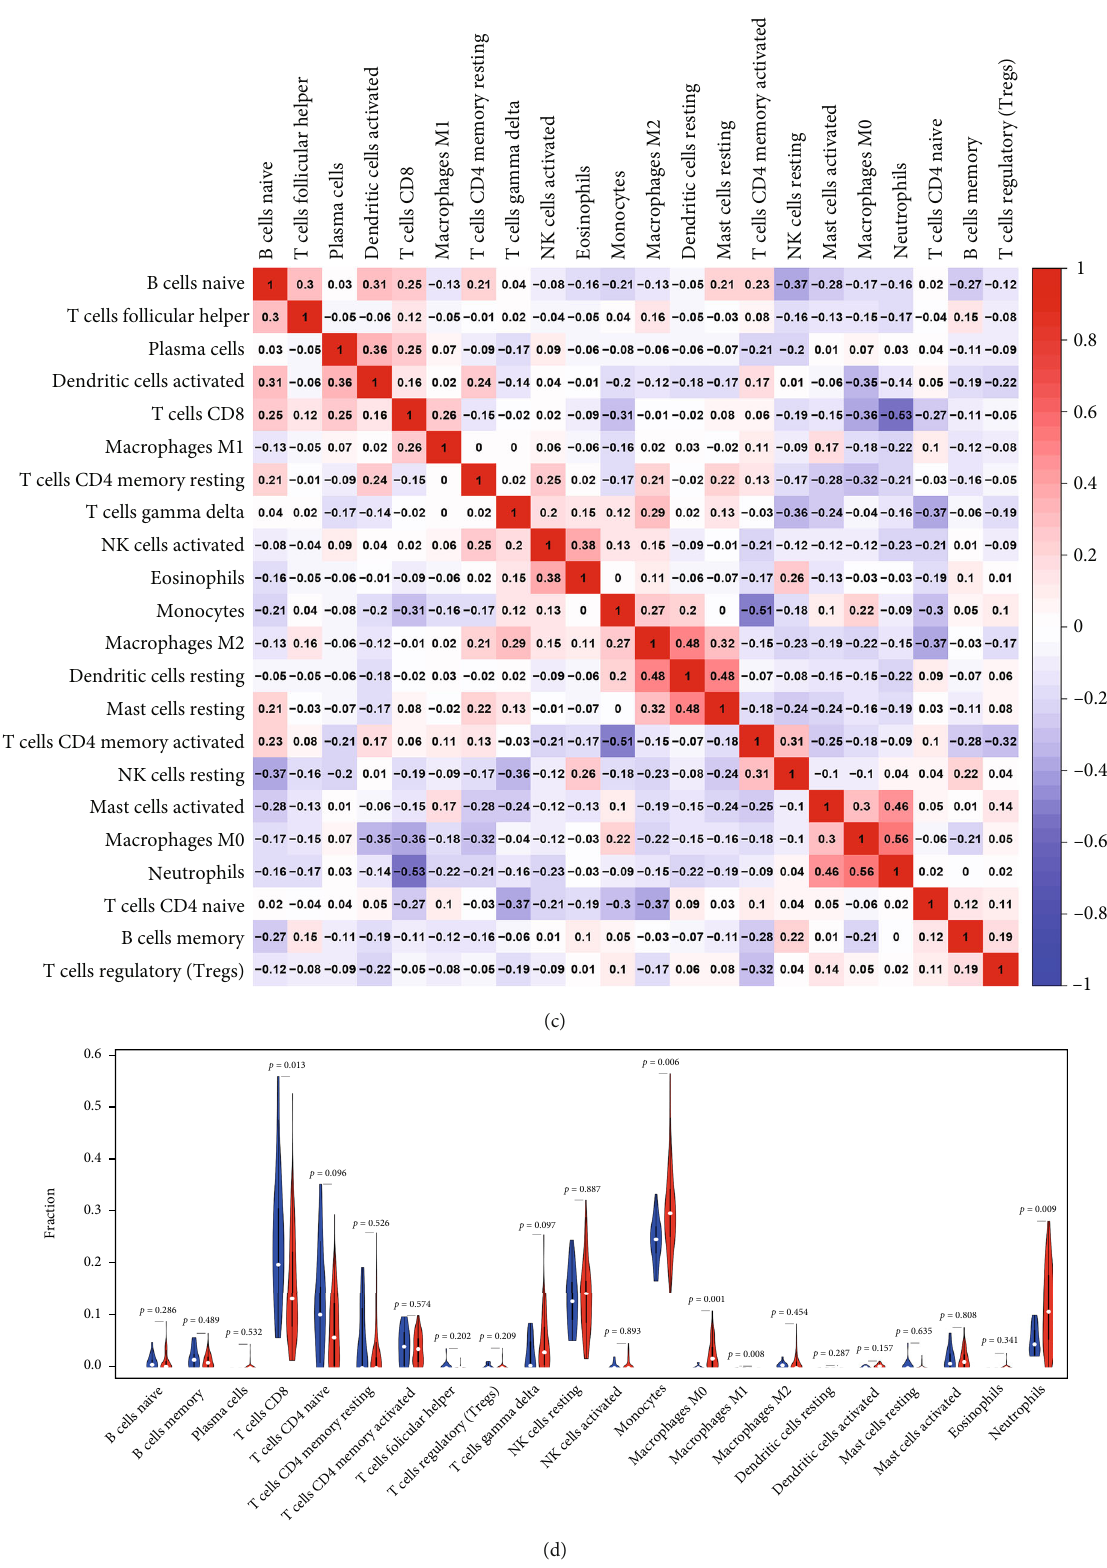
Figure 5: Immunoin fi ltration of IS female and healthy female. (a) Percentage distribution of 22 immune cell subtypes in 96 samples from three datasets. (b) Heat map of the ratio of 22 immune cells in each sample. (c) Related heat maps of 22 immune cells. (d) Violin diagram of the di ff erence in immune cell in fi ltration between female stroke patients and normal